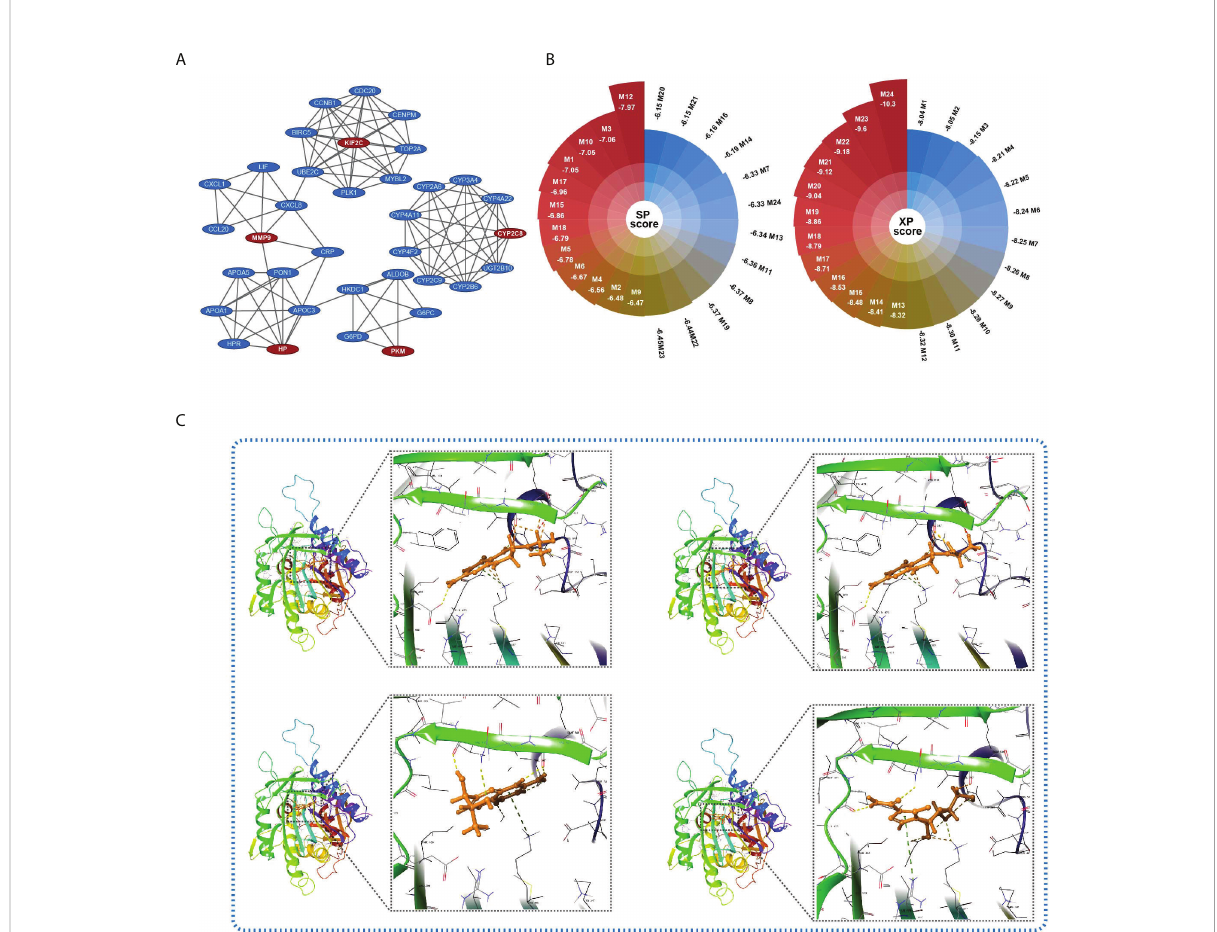
FIGURE 9 Key target identi fi cation and candidate small molecule prediction. (A) Five clusters identi fi ed by the MCODE app of Cytoscape 3.8.2. Red ovals represent “ seed ” nodes and blue ovals represent “ clustered ” nodes. (B) The docking score (XP and SP score) of the top 24 small compounds that bind to KIF2C with the lowest total energy score. (C) Structures and docking models of the top four small compounds (lactoyl-ph4, dihydrobiopterin, 7-biopterin, and mizoribine) and the active site of